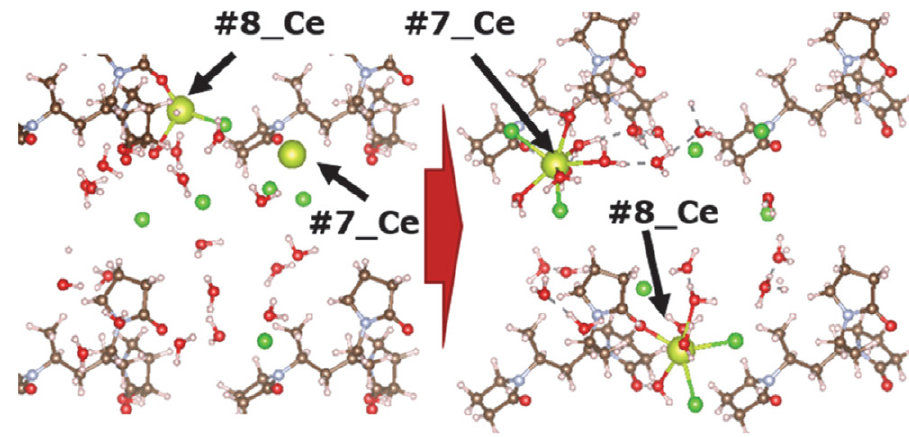
Figure 4. Optimization diagram of each atom in the system before